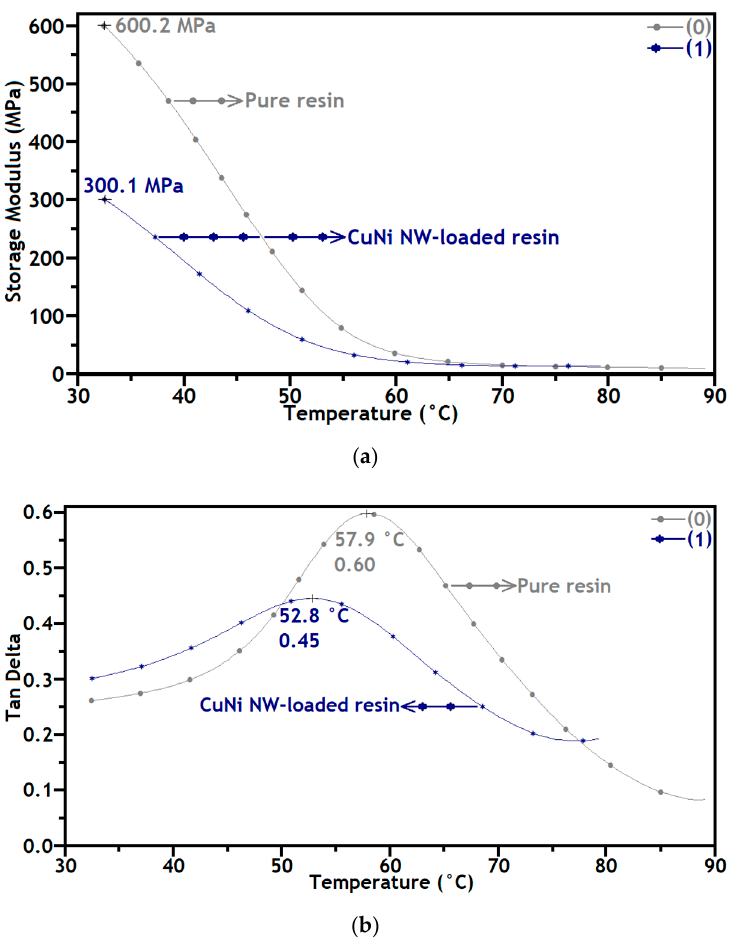
(cid:48) and ( b ) tan δ , as a